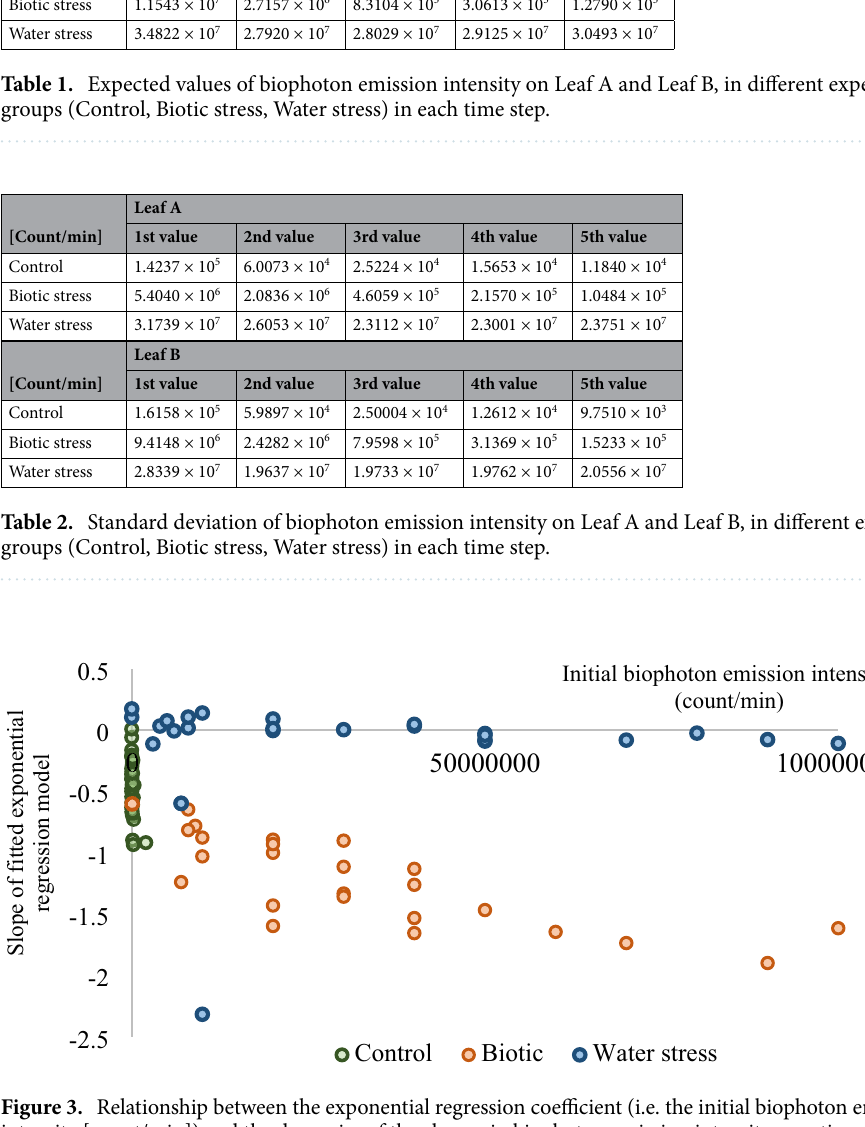
Figure 3. Relationship between the exponential regression coefficient (i.e. the initial biophoton emission intensity [count/min]) and the dynamics of the change in biophoton emission intensity over time (i.e. the slope of the fitted exponential regression model) on Leaf A. The experimental groups (Control, Biotic stress, Water stress) can be clearly